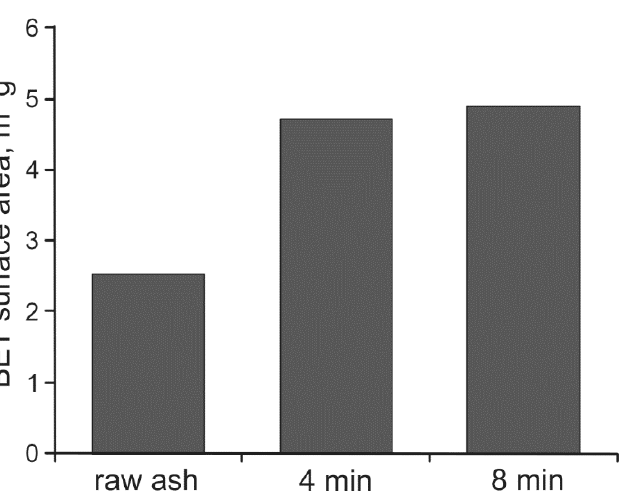
Figure 2. Specific surface area of the raw and mechanically activated ash milled for 4 and 8 min.